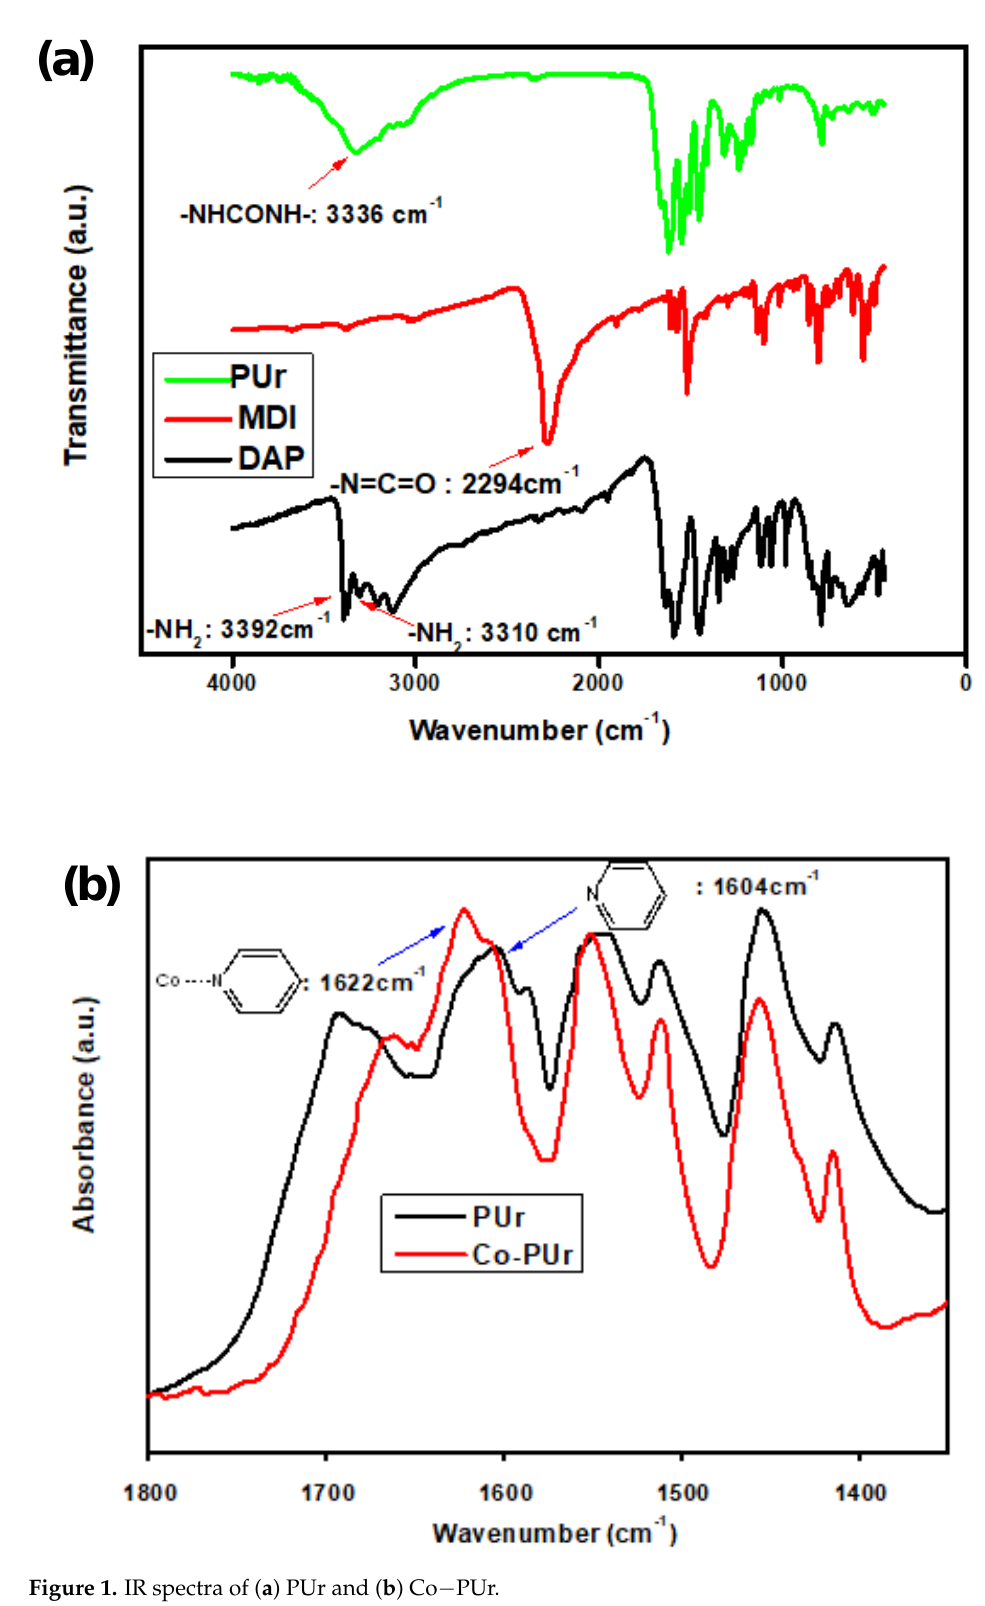
Figure 1. IR spectra of ( a ) PUr and ( b ) Co − PUr.